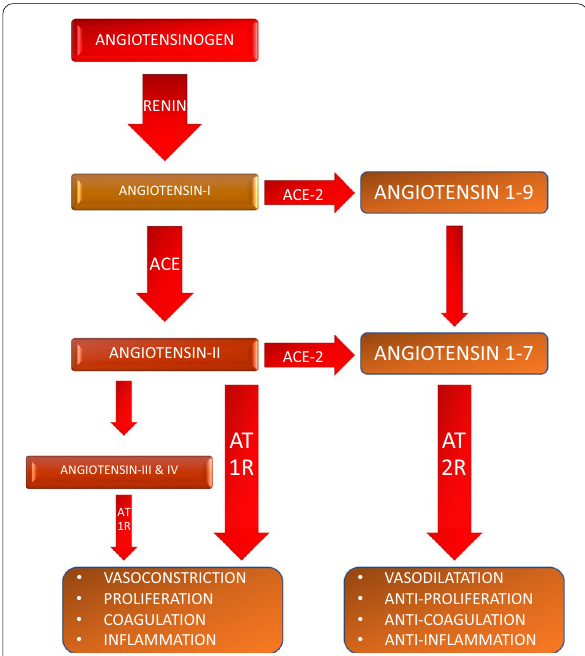
Fig. 1 The renin angiotensin system. ACE: Angiotensin converting enzyme; ACE-2: Angiotensin converting enzyme-2; AT1R/AT2R: Angiotensin I receptor/Angiotensin II receptor; Angiotensin 1–7 and 1–9: shorter peptides of angiotensin